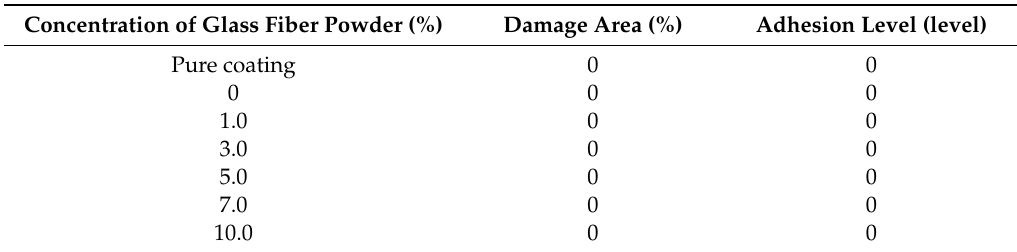
Table 4. E ff ect of glass fiber powder concentration on the adhesion of waterborne coatings with thermochromic ink.